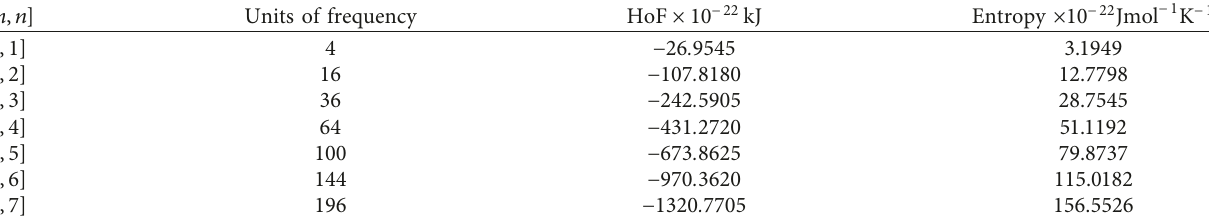
Table 3: Values of HoF and Entropy for units of